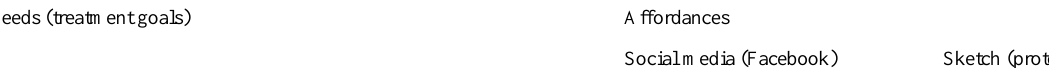
Table 2. The first needs-affordances analysis. AffordancesNeeds (treatment